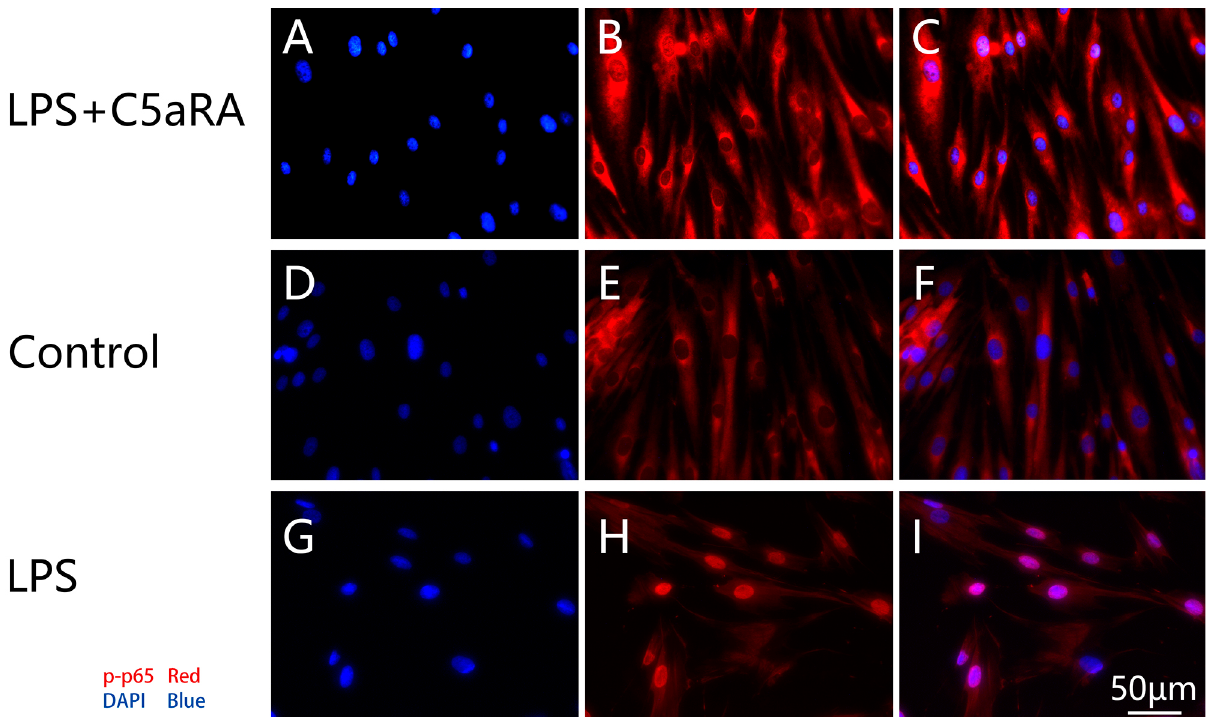
Figure 7- The effects of C5aRA on p-p65 translocation into the nucleus were used to detect by immunofluorescence staining.(A-C) LPS+C5aRA group.(D-F) The control group.(G-I) LPS group. The blue staining represented the nucleus; the green staining was p-p65. Scale bar = 50μm. Fluorescence microscope ×